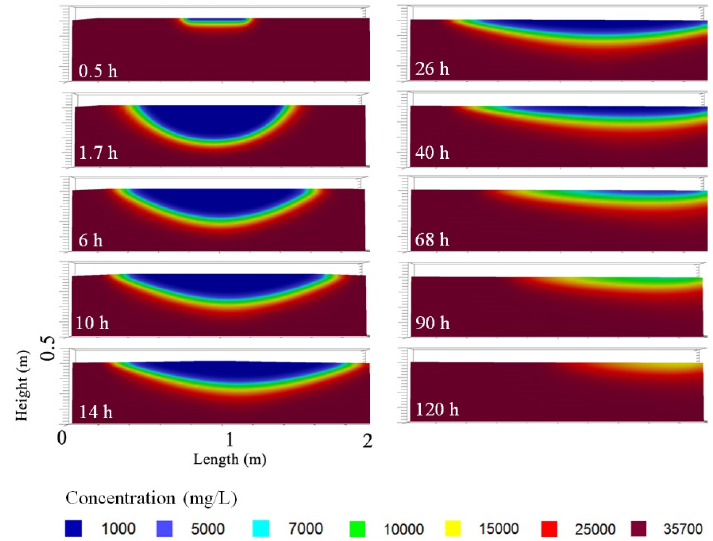
Figure 6. Numerical model Simulation 2 of IFL development and transient evolution. The dimensions of each cross-section match the numerical model domain of 2.0 m (L) × 0.5 m (H) × 0.10 m